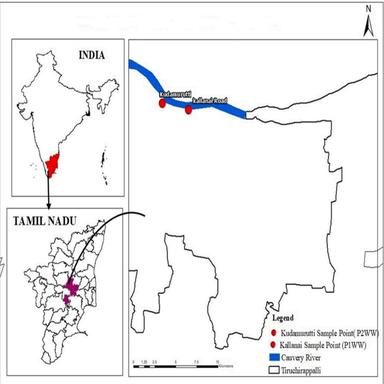
Sampling point for P1WW and P2WW Places.